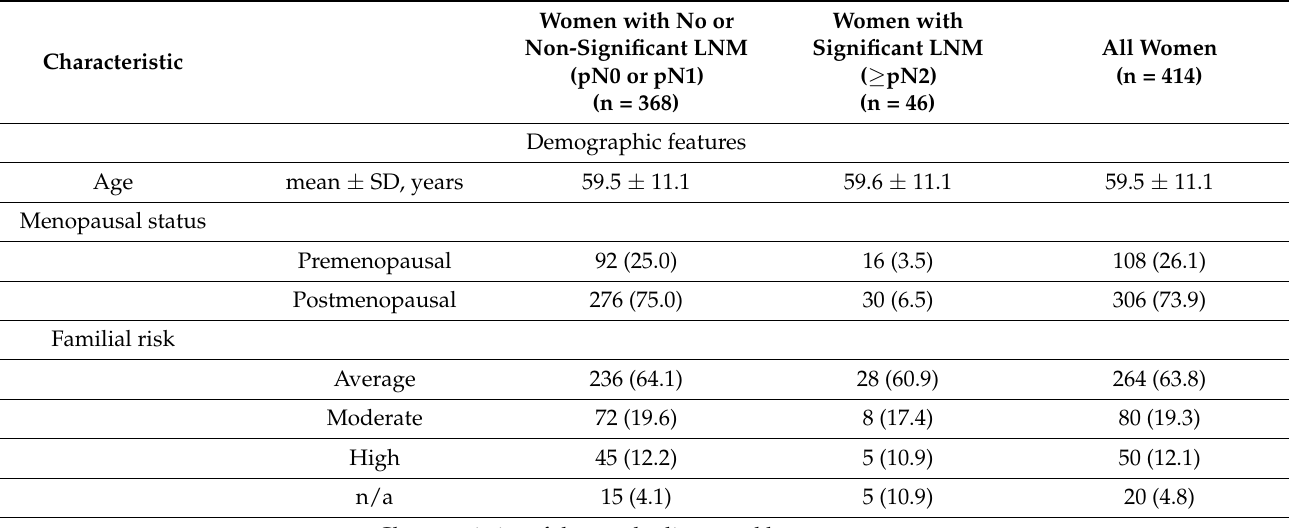
Table 1. Patient demographics and characteristics of invasive breast cancer. Note—data in brackets are percentages. LNM = lymph node metastases, n/a = not available, NST = No special type, SD = standard